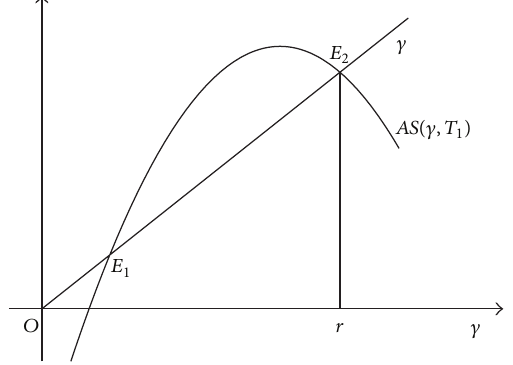
Figure 1: The intersection of curve 𝐴𝑆(𝛾, 𝑇 1 ) and 45-degree